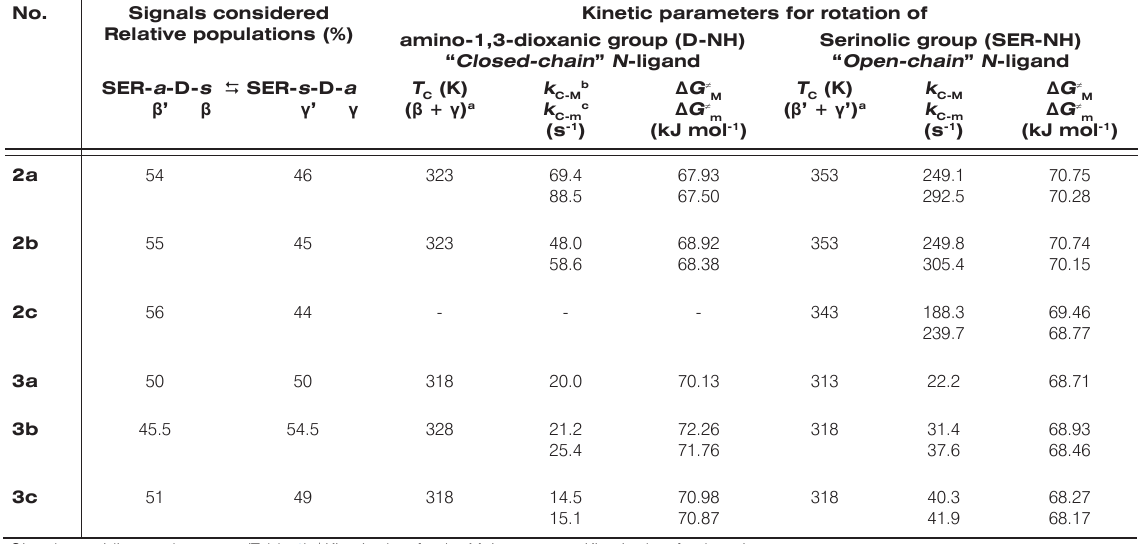
Kinetic parameters for rotation of